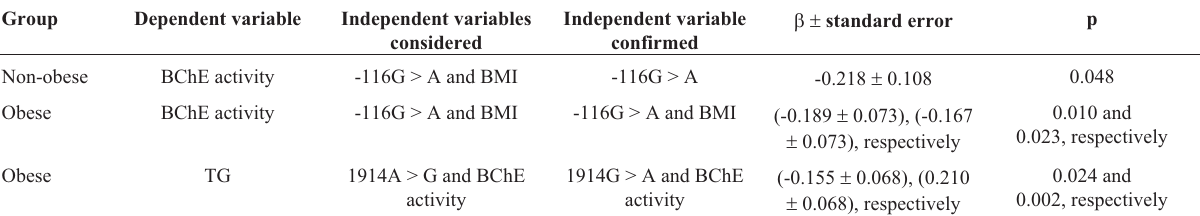
Table 5 - Multiple regression analysis